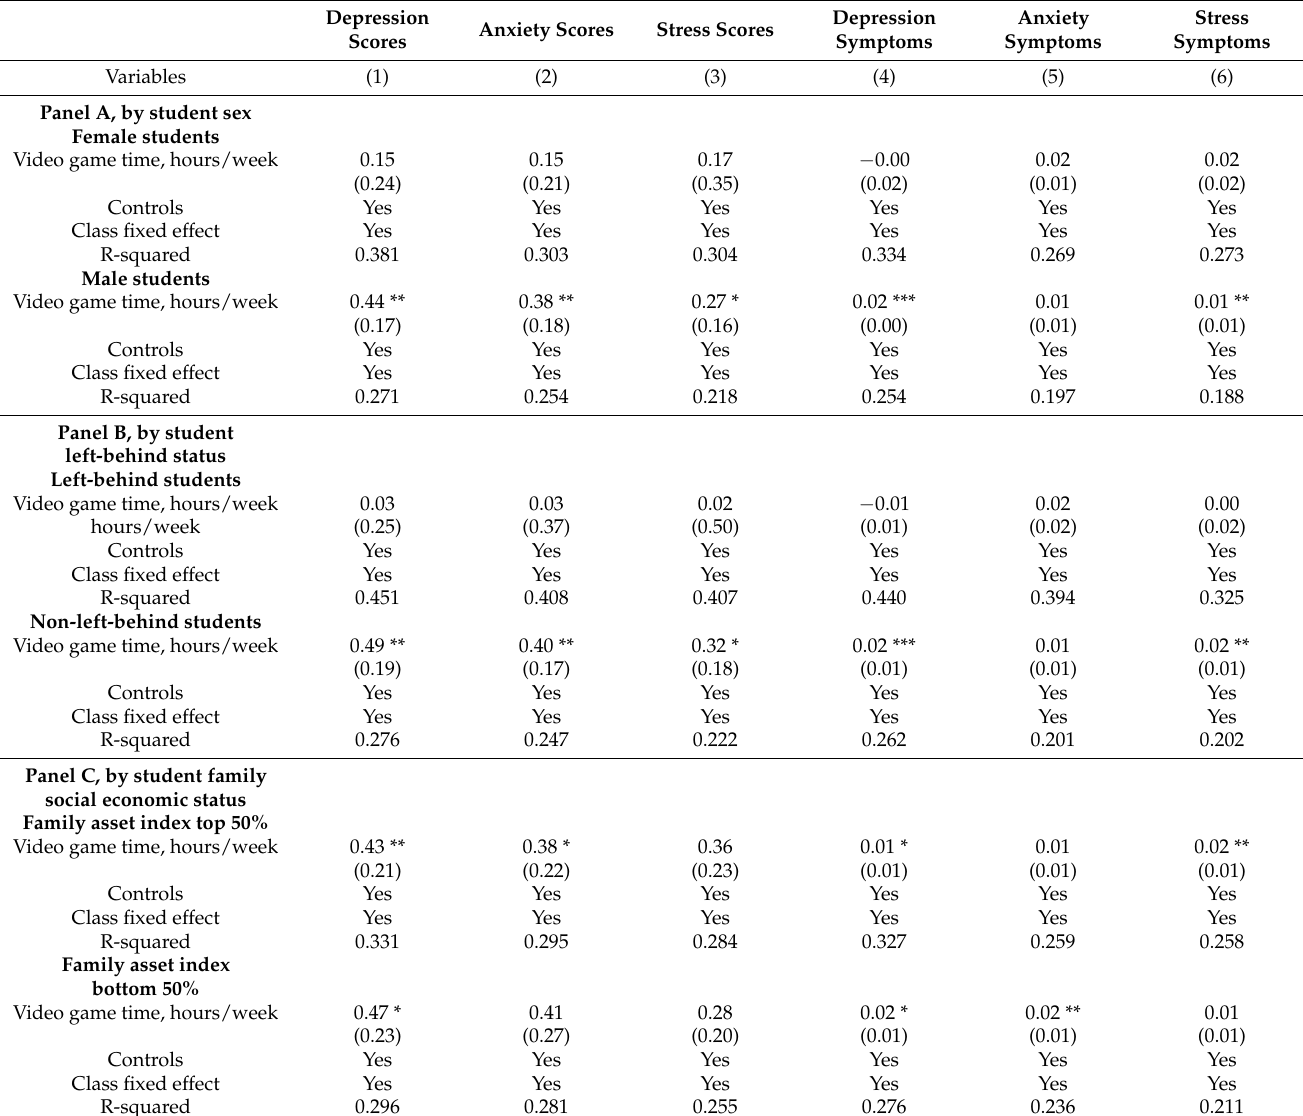
Table 4. OLS regression of weekly video game time on adolescent mental health by groups. Depression Anxiety Scores Stress Scores Scores